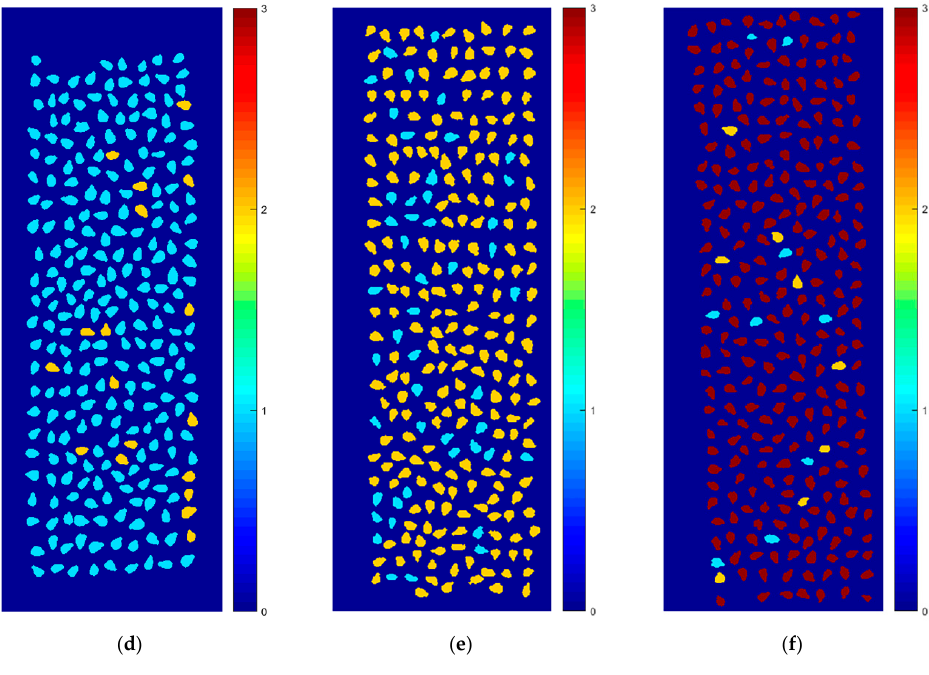
Figure 4. The original grayscale images of ( a ) Variety I; ( b ) Variety II; ( c ) Variety III and the corresponding classification maps of ( d ) Variety I; ( e ) Variety II; ( f ) Variety III.